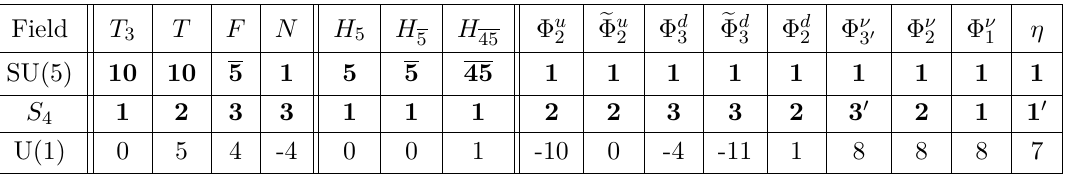
Table 1 . Field content of the model and associated charges and